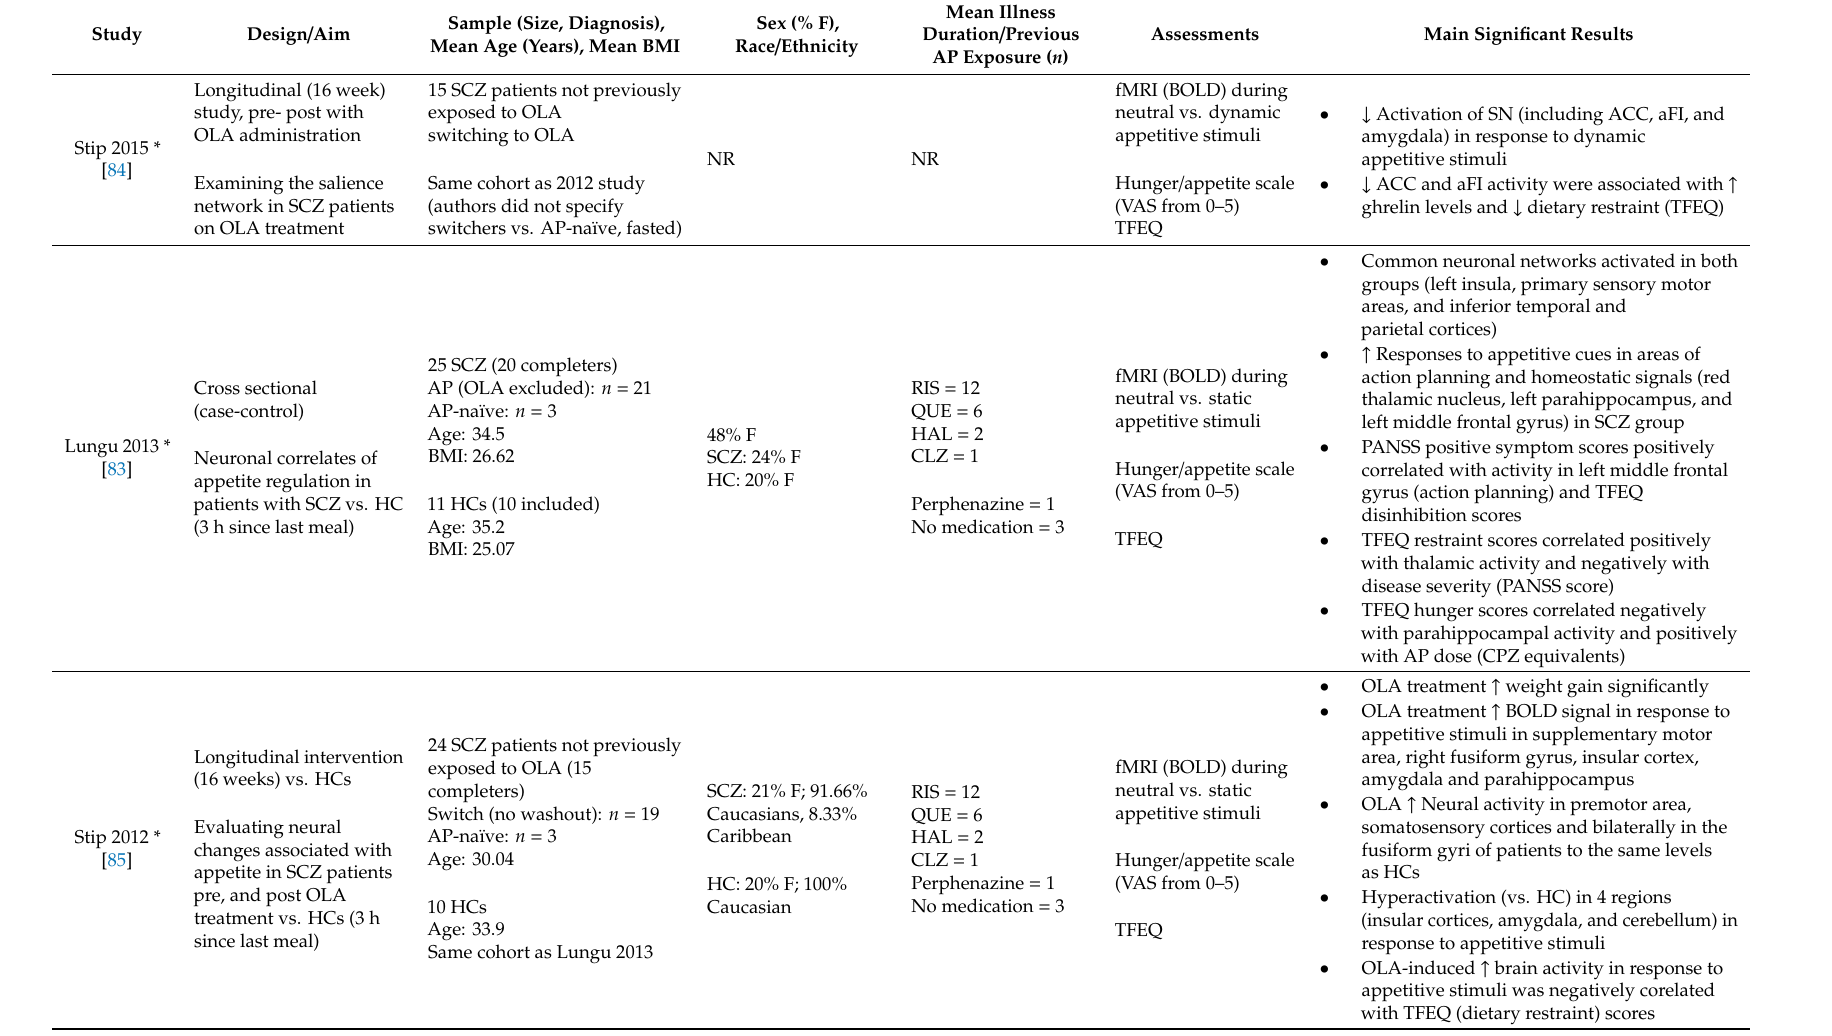
Table 6. Characteristics of studies with neuroimaging